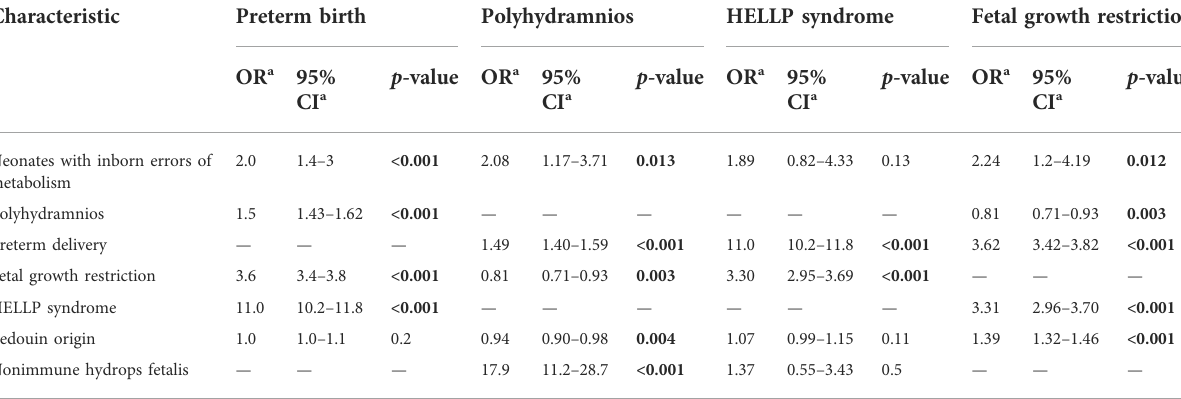
TABLE 6 Multivariate logistic regression — the association between fetal inborn errors of metabolism and pregnancy complications. Characteristic